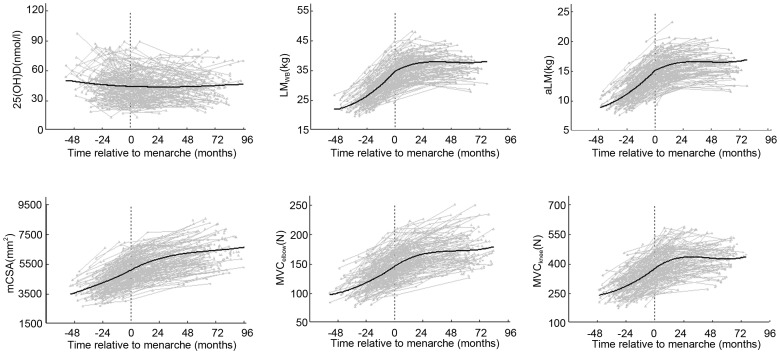
The growth curves of 25(OH)D (a), lean mass(b = LMWB & c = aLM), muscle size (d = mCSA) and muscle strength (e = MVCelbow & f = MVCknee).TRM = time (months) relative to menarche; LMWB = whole body lean mass; aLM = appendicular lean mass; mCSA = muscle cross-sectional area; MVCelbow = maximum voluntary muscle contraction of elbow flexors; MVCknee = maximum voluntary muscle contraction of knee extensors. Grey dots and lines indicate individual values and the black solid line indicates the best fitting of growth pattern by hierarchical modelling.